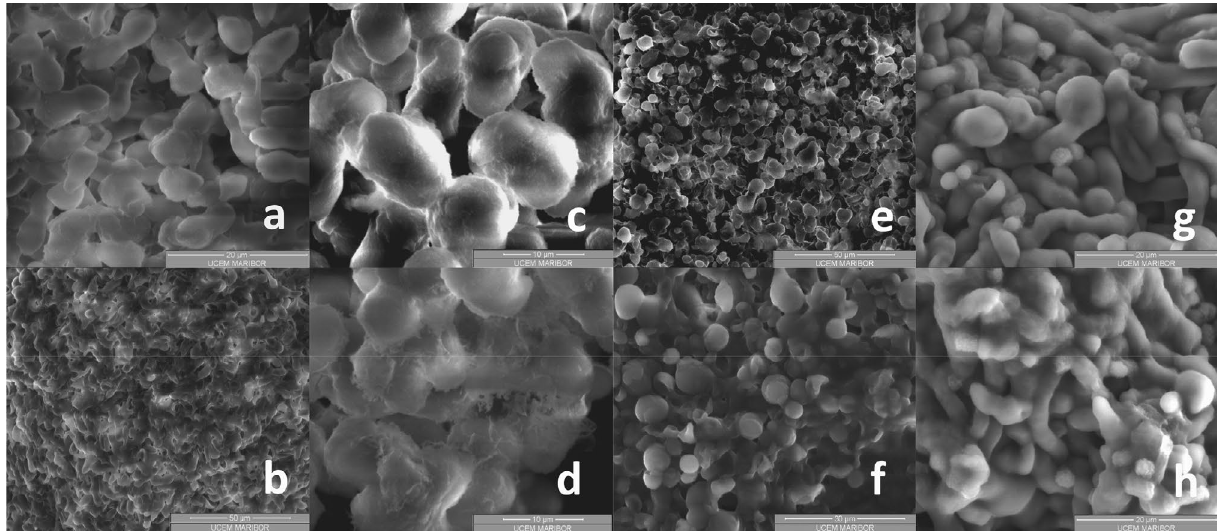
Figure 2: Halophilic fungi cells observed under an environmental scanning electron microscope (ESEM). H. werneckii cells a) before (magnification: 3000 X) and b) after 100 min of homogenization, T. salinum cells (magnification: 1000 X) c) before (magnification: 4000 X) and d) after 100 min of homogenization, P. triangularis cells (magnification: 4000 X) e) before (magnification: 1000 X) and f) after 100 min of homogenization and W. ich- thyophaga (magnification: 2000 X) g) before (magnification: 3500 X) and h) after 100 min of homogenization (magnification: 3500